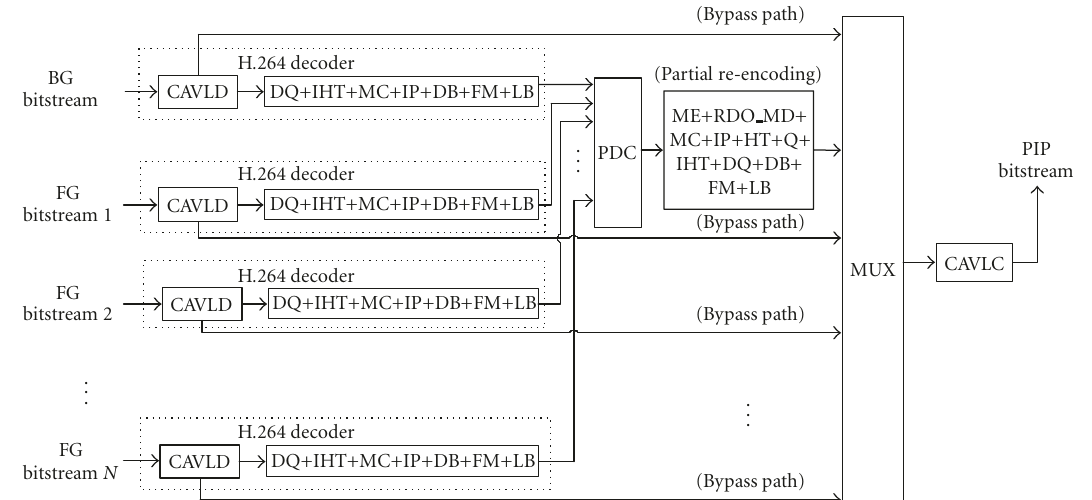
Figure 4: Initial architecture of RFMT with RDO refinement based on the partially reencoding.